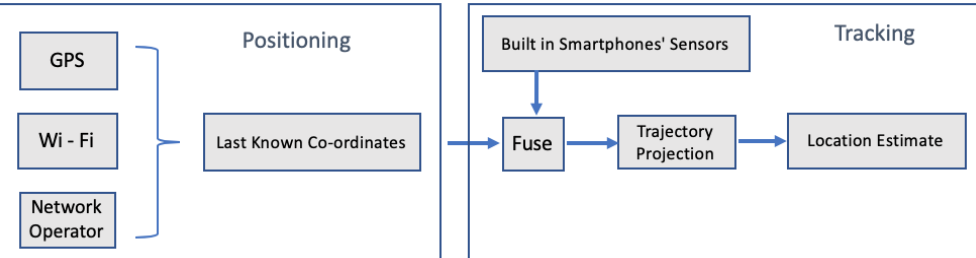
Figure 11. Hybrid location estimation solution as presented in Reference [51].